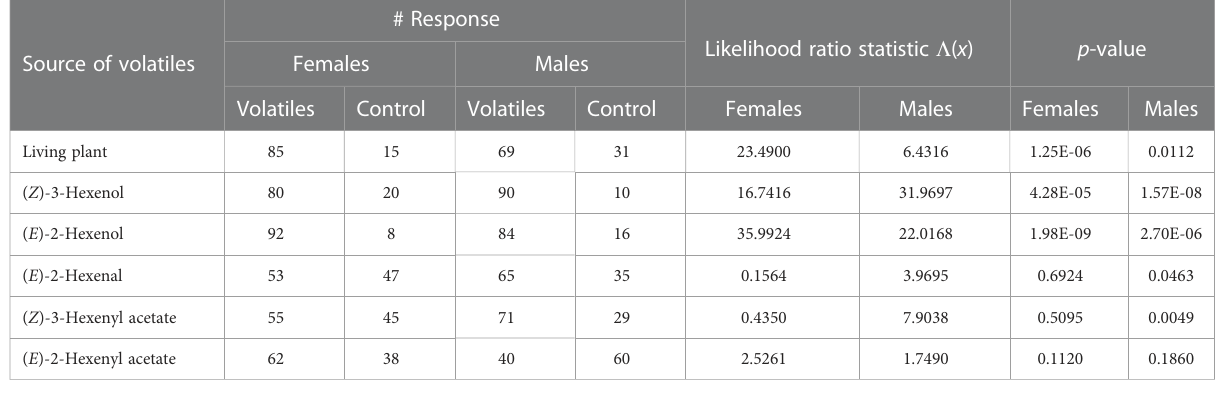
TABLE 1 Responses of Diaphorina citri adults to tobacco plant and synthetic standards of green leaf volatiles